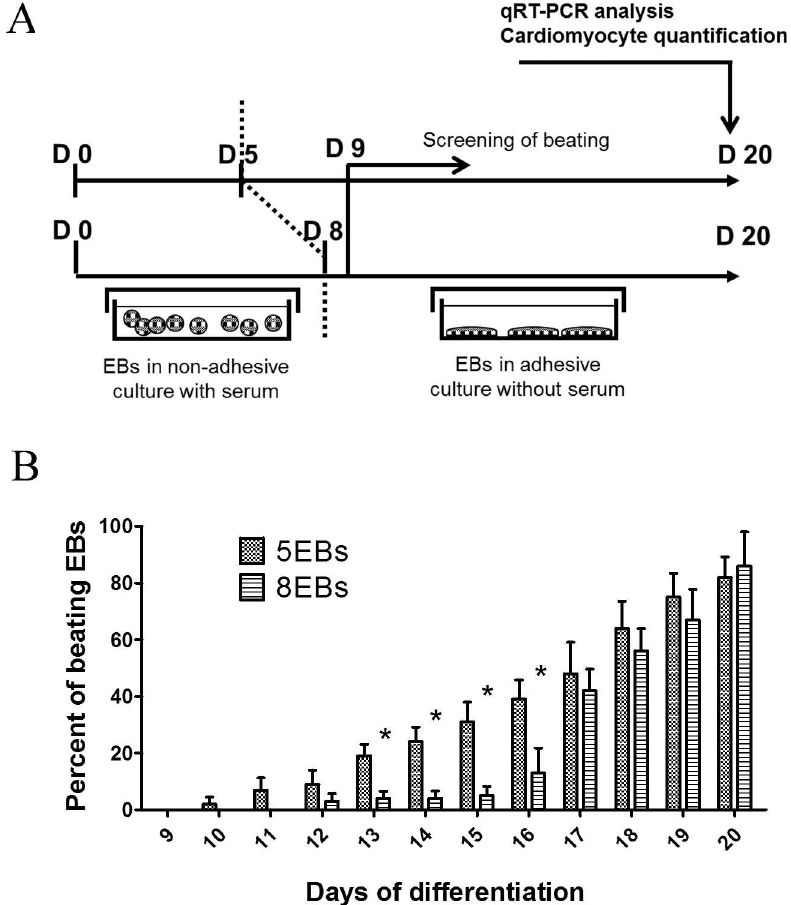
Fig 1. The experimental setup employedfor comparisonof the effects of different durations(5 vs. 8 days) of EBs cultivationunder non-adherent conditions on cardiacdifferentiation analyzedby the determination of the percentage of beatingEBs duringcultivationand the expressionof cardiomyogenic markers at the end of the differentiation experiment (A). Percentage of beatingEBs in the adherentlayer duringthe differentiationof mouse ES R1 cells that were primarily cultivatedin the form of EBs under non-adherent conditions for 5 days or 8 days (B). Data are expressedas mean ± SEM (n = 4). Differences betweensamples were analyzedby ANOVA with Bonferroni’s MultipleComparisonTest and considered statistically significantfor p (cid:20) 0.05; they are marked with asterisks.